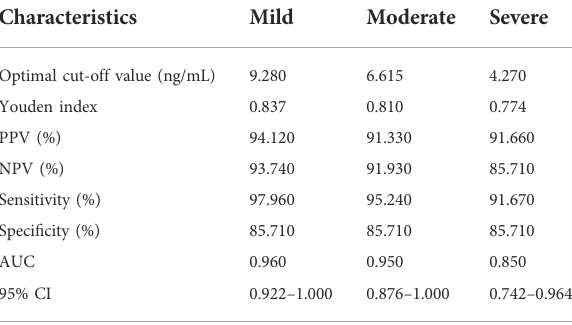
TABLE 2 Diagnostic ability of 4-PPanSH in patients with different grades of CHD. Characteristics Mild Moderate